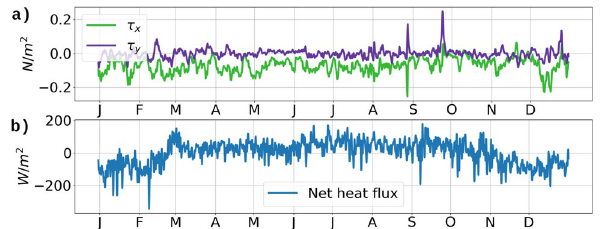
Figure 2. ( a ) 6-hourly averaged wind stress from CERSAT in 2019. ( b ) Hourly net heat flux from the Atlantic PIRATA moored buoy in 2019. The data plotted here are lowpassed with a 1 / 24 hr data was used in the